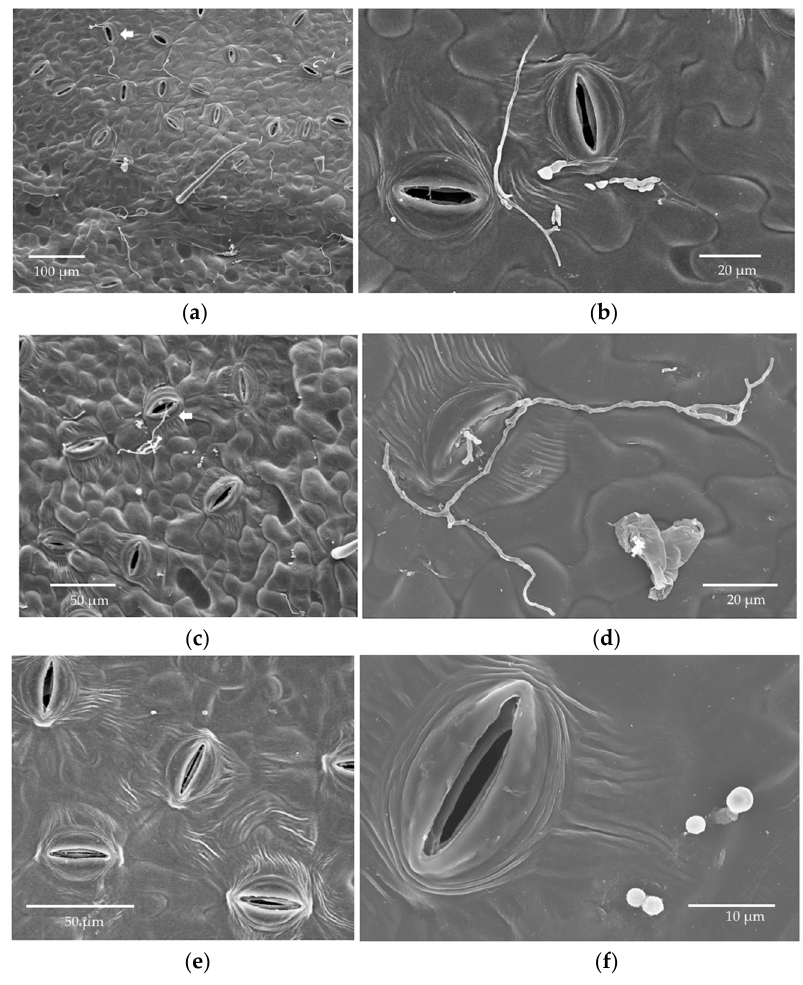
Figure 10. SEM photos of samples from in planta inoculations, 14 DAI. White arrow: hyphal entry through stomata. ( a , b ) Cladosporium ; ( c , d ) Penicillium ; ( e , f ) Trichoderma .